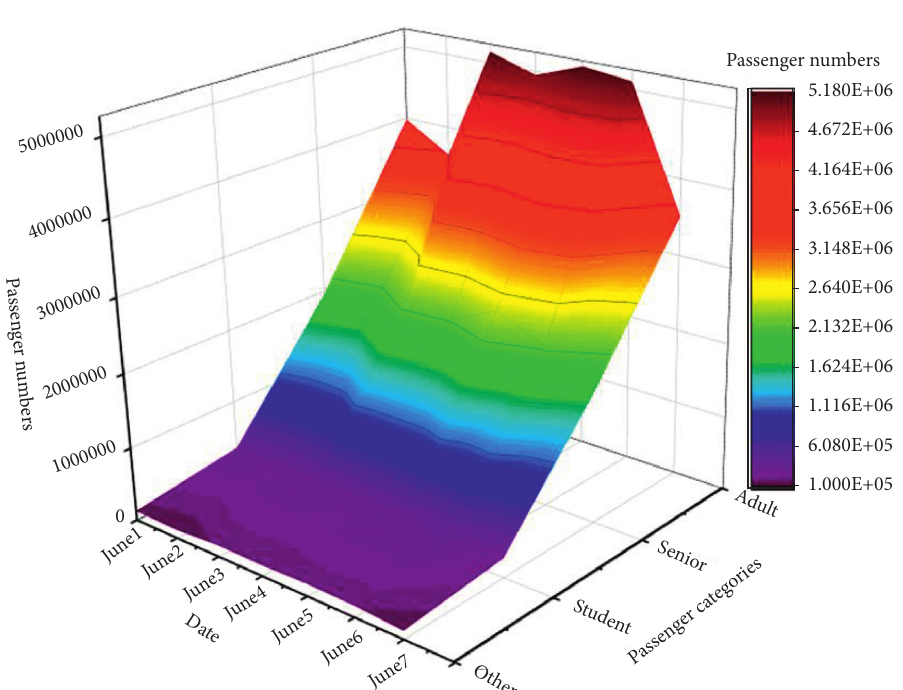
Figure 4: Day-to-day changes in the number of every category passengers.